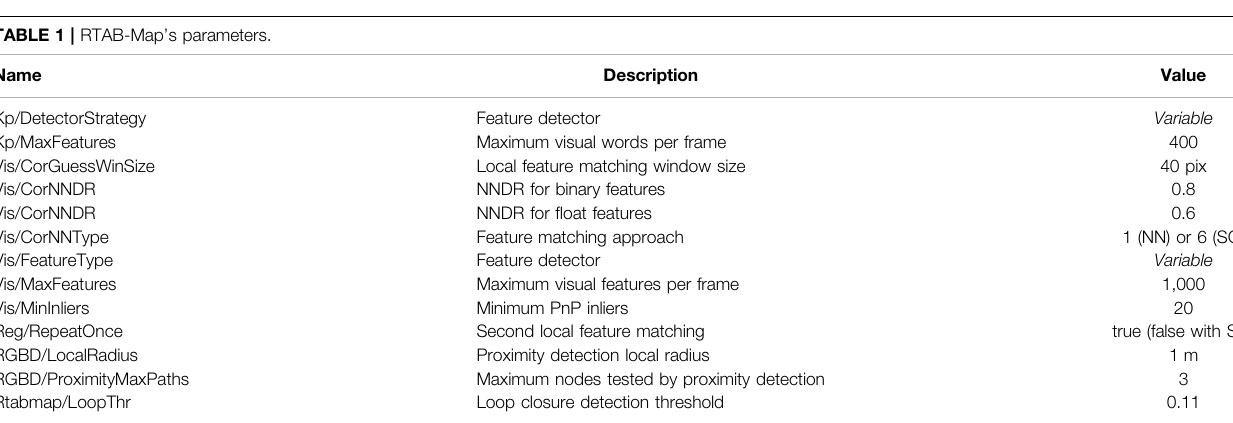
TABLE 1 | RTAB-Map ’ s